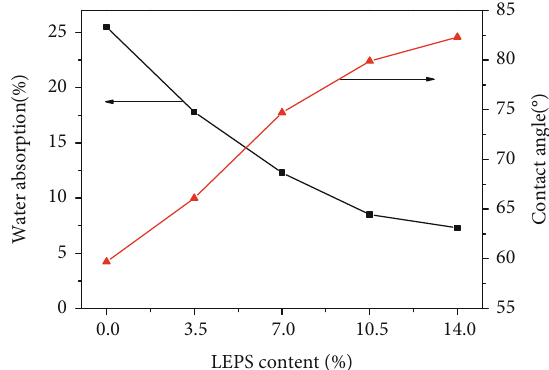
Figure 4: E ff ect of LEPS content on water absorption and contact angle of WPU fi lms.